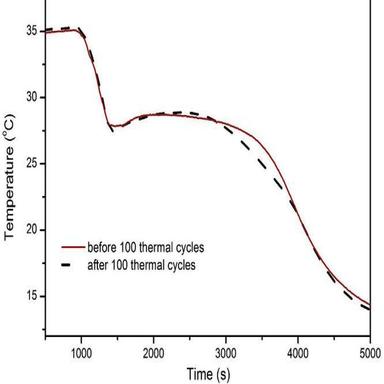
Cooling curves of CaCl2·6H2O with CsxWO3 nanoparticles before and after 100 thermal cycle tests.